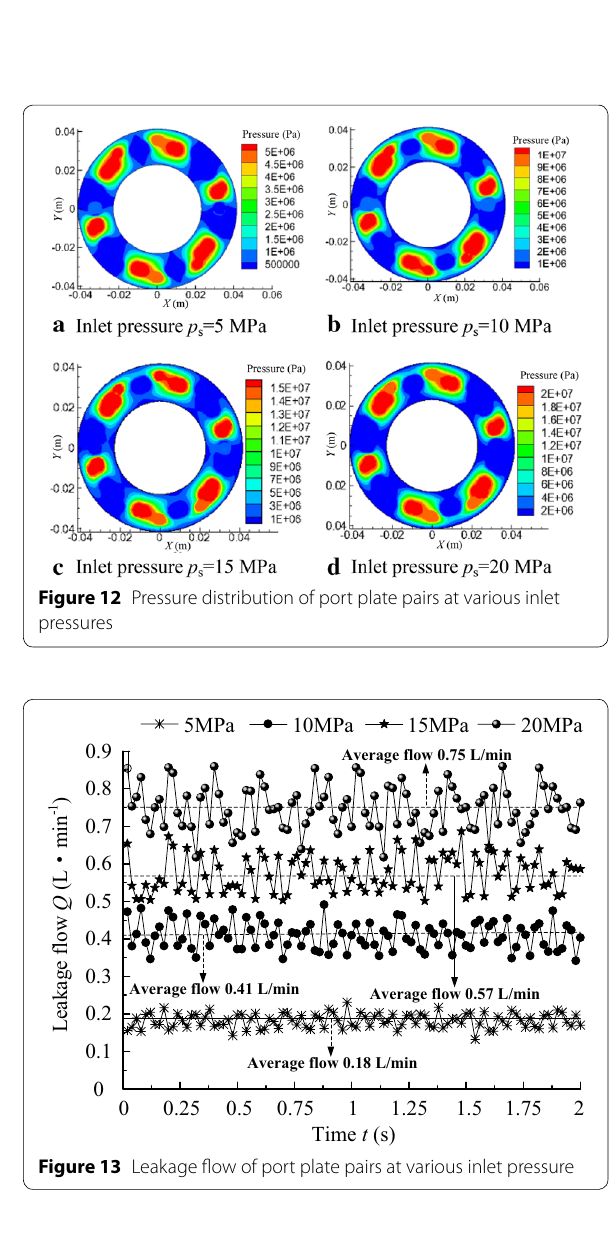
0.300.350.400.450.50